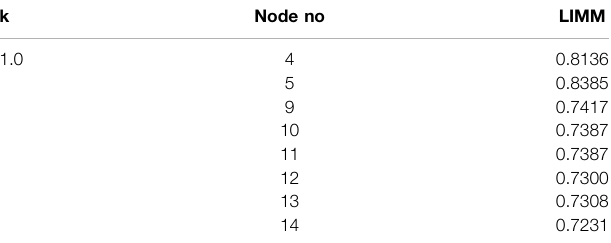
FIGURE 4 | IEEE 14-bus system wiring diagram. TABLE 1 | LIMM values of IEEE 14-bus system.